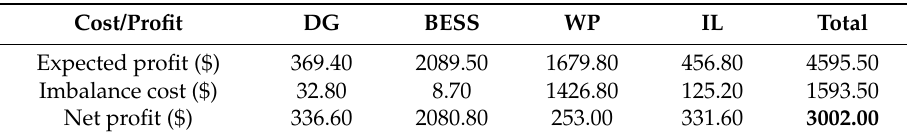
Table 1. Profits and costs for VPP components in Case 1.